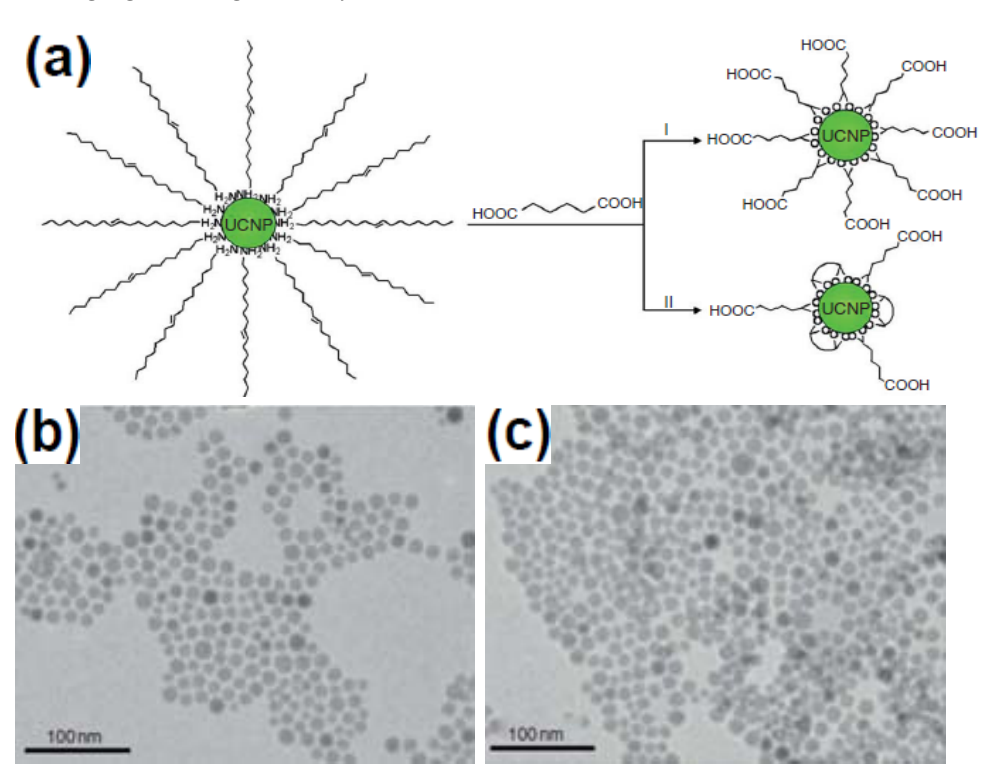
Figure 11. ( a ) Schematic illustration showing the ligand-exchange reactions on OM-stabilized upconversion nanophosphors. ( b , c ) TEM images of NaYF 4 :Yb/Er nanophosphors prior to and after ligand exchange reactions, respectively. Reproduced from [114]. Copyright 2006, John Wiley and